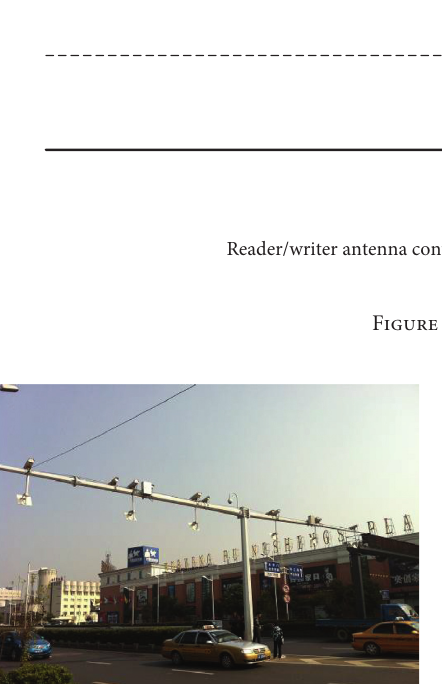
Figure 2: Picture of the actual